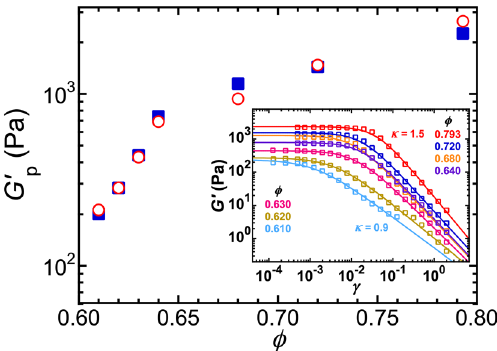
Figure 6. Comparison of DWS-GSER microrheological plateau elastic shear moduli, G ′ p,GSER (φ) (red open circles), obtained using plateau MSDs from Fig. 3a and the E-DCSN model’s α(φ) from Fig. 5b, with plateau elastic shear moduli G ′ p,mech (φ) measured by mechanical rheometry (blue solid squares, from fits to strain- dependence in the inset). Inset: Mechanical shear oscillatory measurements of the storage modulus G ′ as a function of the applied peak strain amplitude γ for intermediately attractive dense emulsions at [SDS] = 35 mM κ + 1 (cid:28) , yielding the plateau shear and frequency ω = 1 rad/s. Solid lines: fits using G ′ (γ) = G ′ p,mech / (cid:31)(cid:30) γ/γ y (cid:29) modulus G ′ p,mech ; yield strain γ y indicates the position of the knee that defines yielding; and high-strain power law parameter κ describes the decrease in the non-linear G ′ well beyond